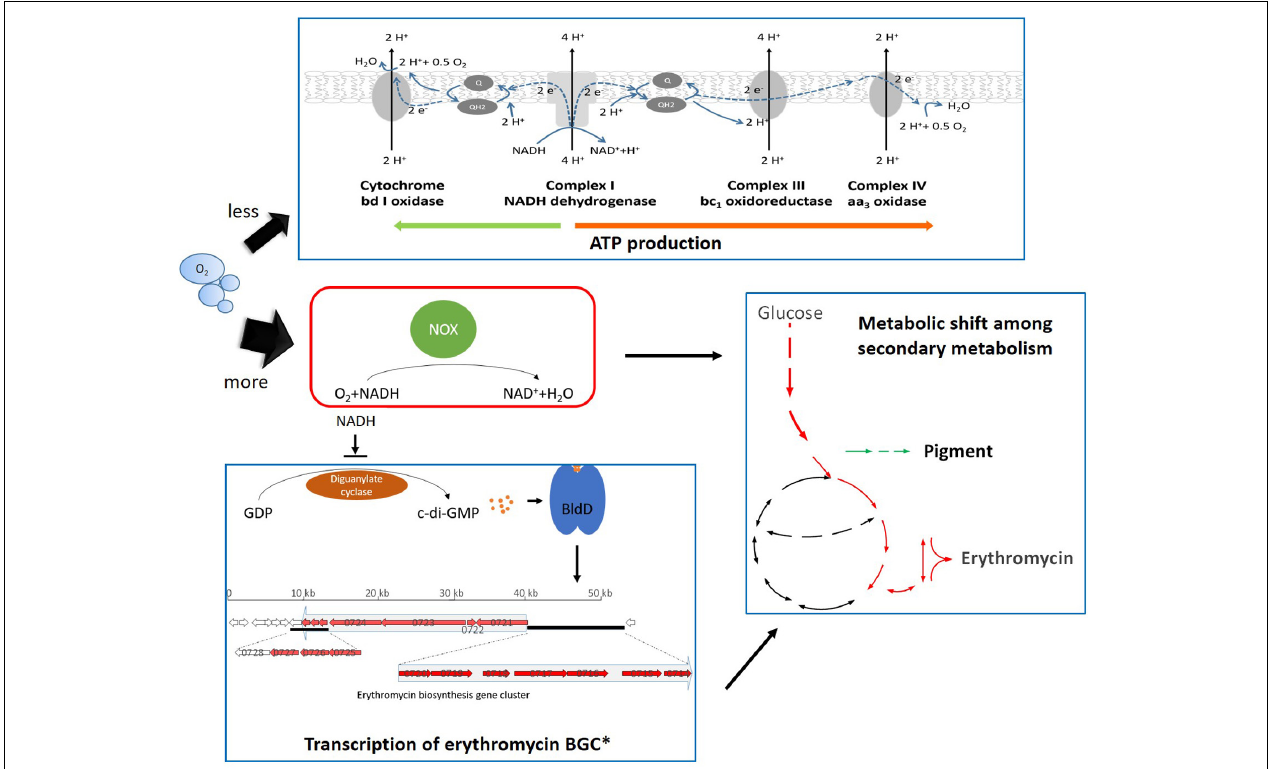
FIGURE 9 | Schematic representation of the cellular response toward the expression of NOX in S. erythraea . Black thin arrows refer to positive regulation; the thin arrows ended by a perpendicular short line refer to negative regulation. Green arrows beside Pigment indicates down-regulation, while red arrows beside Erythromycin indicates up-regulation. * refers to 2 previous studies (Chng et al., 2008; Xu et al.,